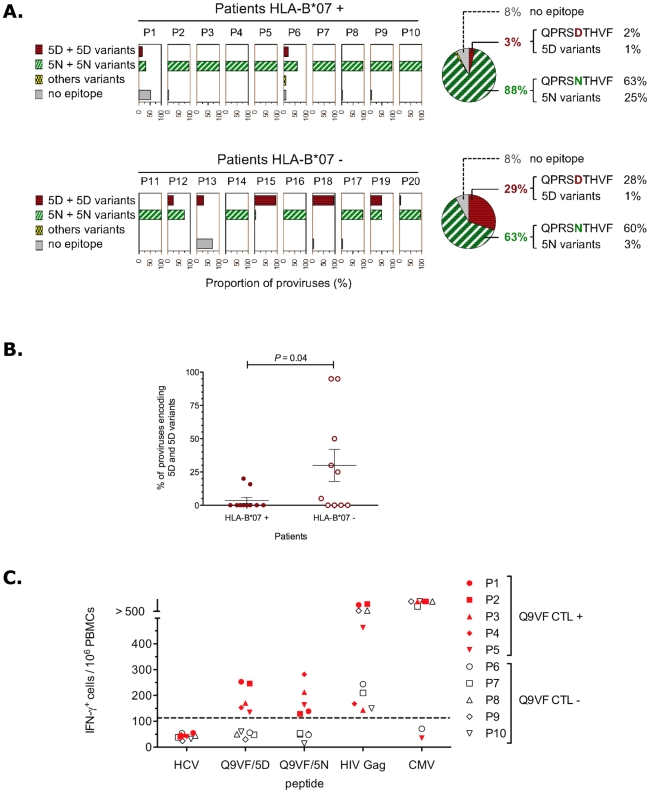
Q9VF/5D-specific CTLs exert a selection pressure on HIV Q9VF
gag-overlapping ARF.(A) Analysis of Q9VF proviral sequences in HIV-infected
donors. Using PBMCs, proviral DNA of 20 HIV+ individuals were
extracted and the region corresponding to gag-ARF
PCR-amplified and cloned. Twenty clones per donor were sequenced.
Results are presented as percentage of provirus encoding for Q9VF/5D and
5D variants exhibiting within the epitope an additional AA difference
from the consensus sequence, Q9VF/5N and 5N variants, and sequence
harboring a stop codon prior the epitope (no epitope). Pies on the right
represent percentage of provirus combined for all isolates. Top and
bottom panels, results for HLA-B*07+ and HLA-B*07- donors,
respectively. (B) Percentage of provirus encoding Q9VF/5D
or 5D variants within HLA-B*07+ and HLA-B*07- patients.
Each dot represents percentage within the PBMCs of one donor. In
HLA-B*07+ patients, variants with 5D are under-represented
(P<0.04). (C) Immunogenicity of Q9FV peptide variants.
PBMCs of HIV-infected HLA-B*07+ donors were loaded with
peptides and T cell activation monitored by IFNγ-ELISot. PBMCs were
incubated with HLA-B*07-restricted epitopes: Q9VF/5D, Q9VF/5N, a
pool of 3 immunodominant HIV-1 Gag epitopes (SPRTLNAWV, TPQDLNTML,
YPLASLRSLF), a CMV-derived epitope (pp65 TPRVTGGGAM) or an HCV-derived
epitope as negative control (GPRLGVRAT). Out of 31 HLA-B*07+
patients 5 reacted to Q9VF/5D and Q9VF/5N. Results for the 5 Q9VF
reacting patients (Q9VF CTL +, full symbols) and 5 representative
Q9VF non-reacting patients (Q9VF CTL-, open symbols) are shown. Data are
means of triplicates. Dotted line indicates threshold of significant
positive responses.